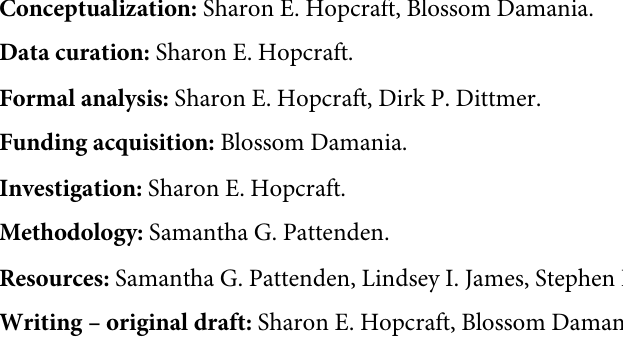
S1 Fig. Inhibitor screen for epigenetic regulatory proteins that induce KSHV reactivation from latency in 293-KSHV.219 cells. 293-KSHV.219 cells were incubated with 1 μM of each compound for 48 hours in (A) or 10 μM of each compound for 120 hours in (B), and the per- centage of GFP positive cells expressing RFP (percent reactivation) was determined by FACS analysis. Data are representative of two independent experiments performed in duplicate; mean and standard error are shown. S1 Table. List of compounds included in epigenetic inhibitor screen and their cellular tar-